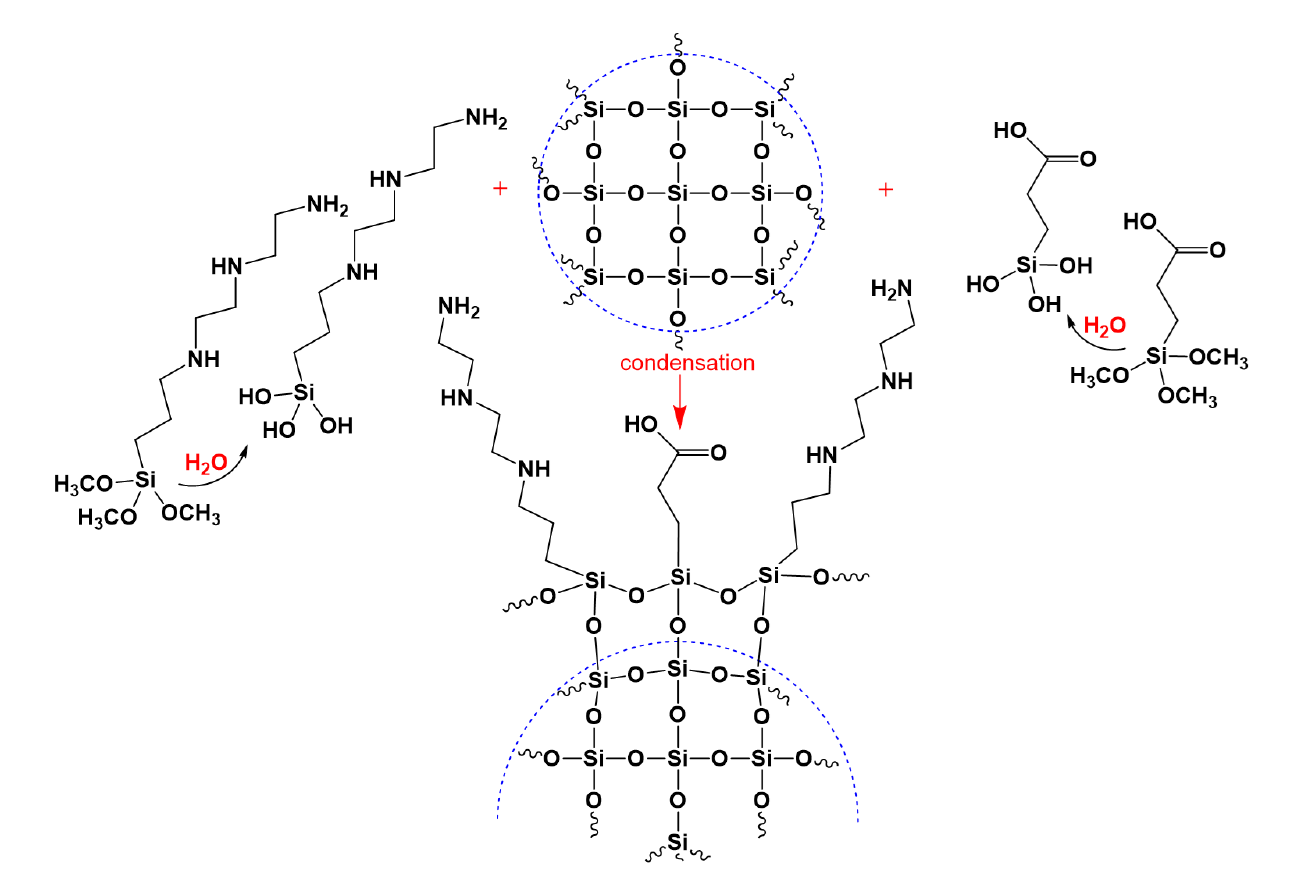
Figure 1. Schematic illustration of silica particles modified with DETAS ( left ) and CEST ( right ).